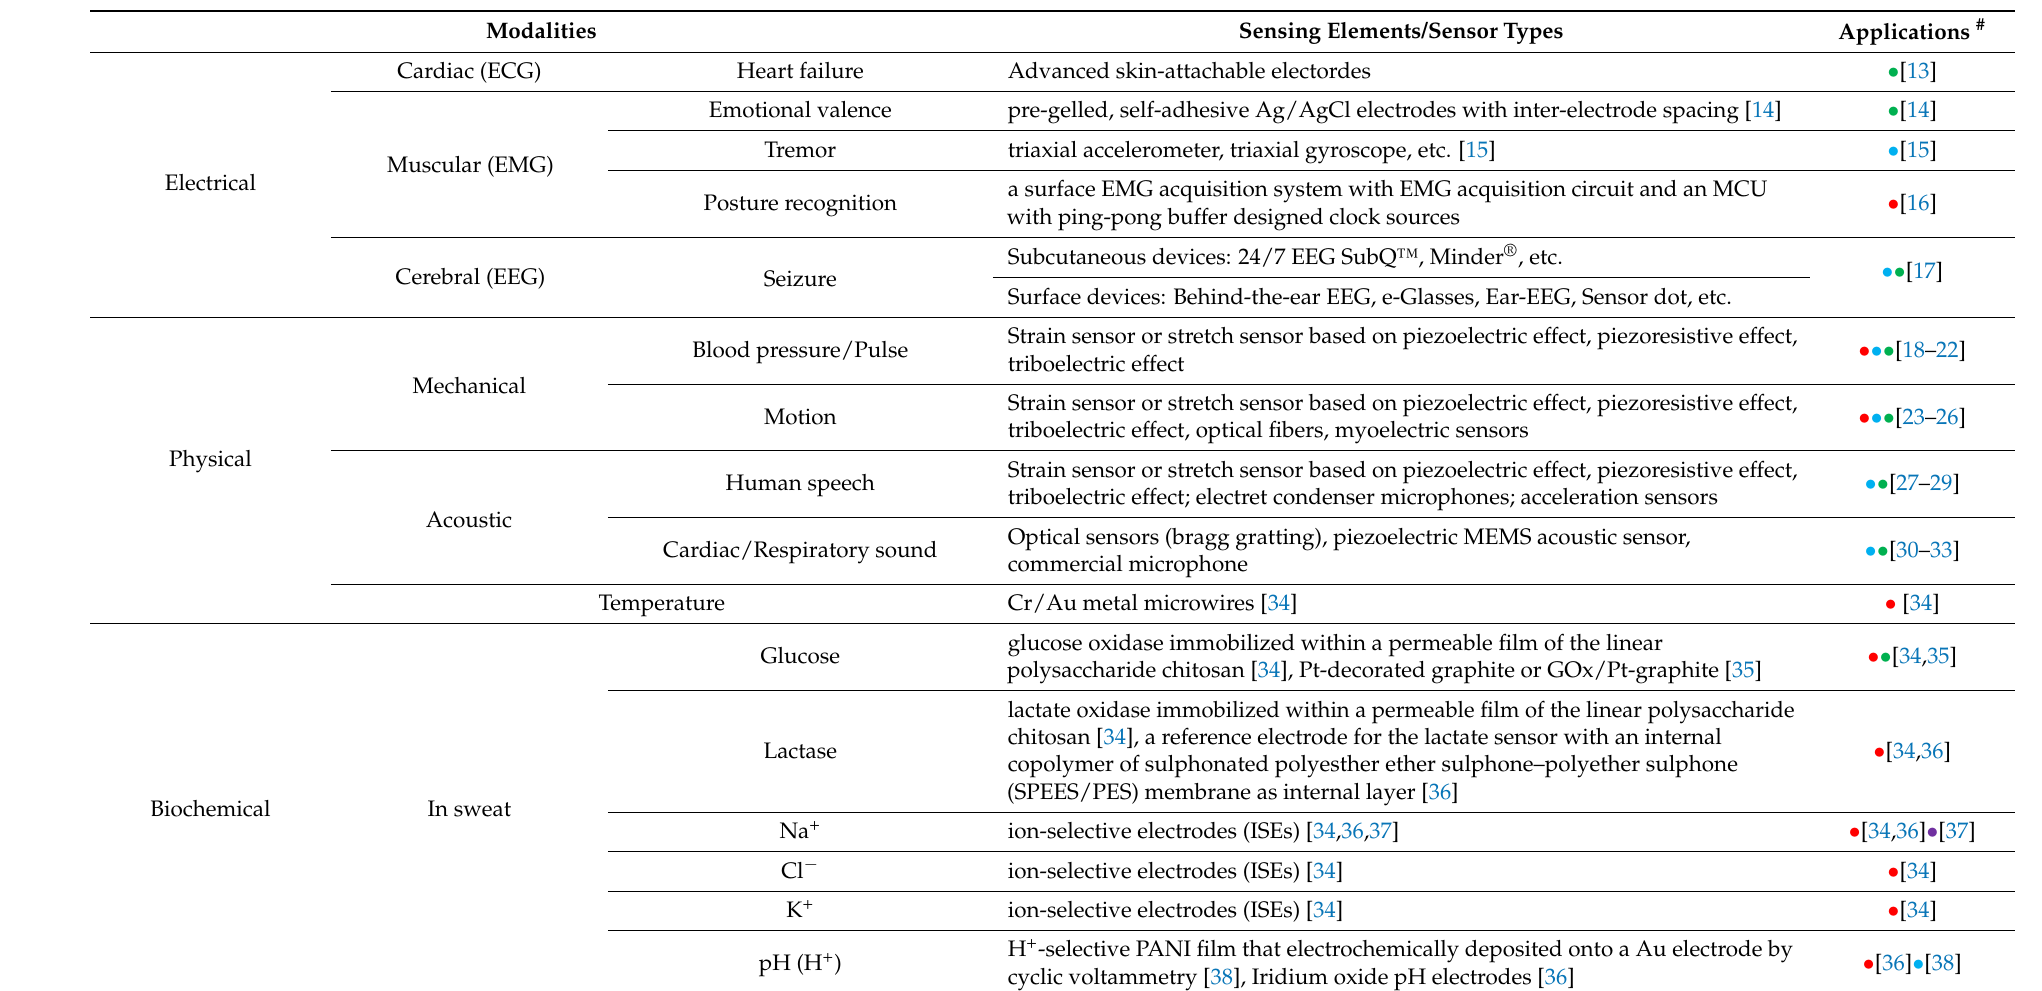
Table 1. Different modality of detection in wearable biosensor